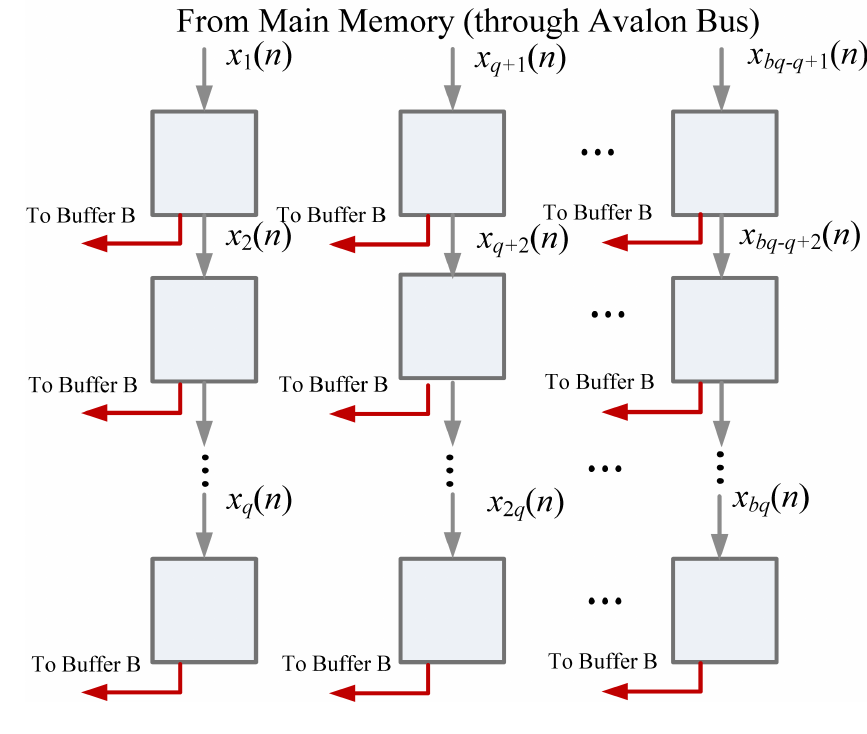
Figure 7. The Buffer A architecture in memory unit.